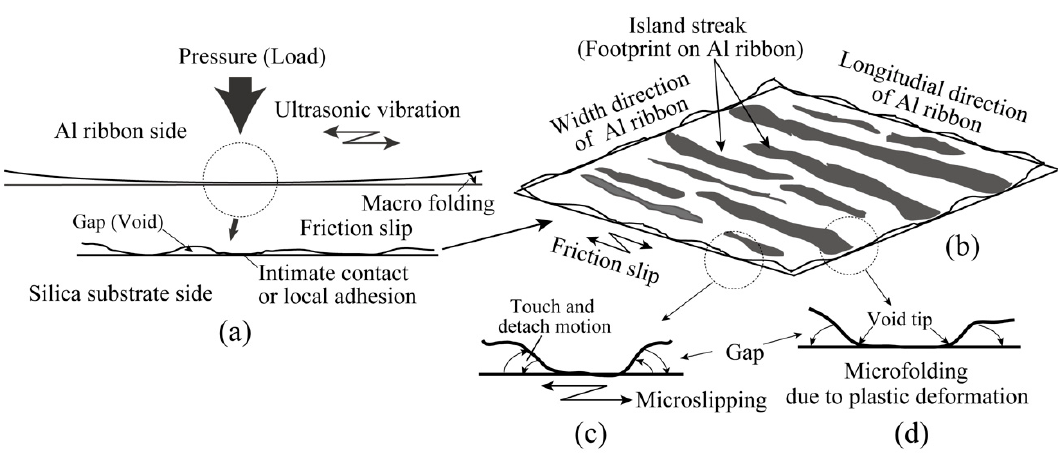
Figure 13. Schematic illustrations of bonded interface between Al ribbon and silica substrate; ( a ) Cross section parallel to US direction; ( b ) Drawing of bonded interface and island streaks; ( c ) Microslipping produced in longitudinal direction of Al ribbon; ( d ) Microfolding at void tip produced in width-direction of Al